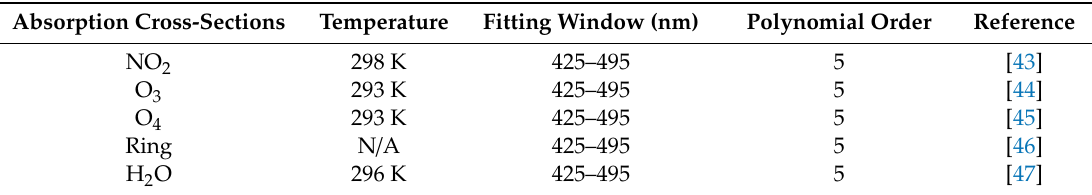
Table 3. The main settings used for the NO 2 spectral analysis.